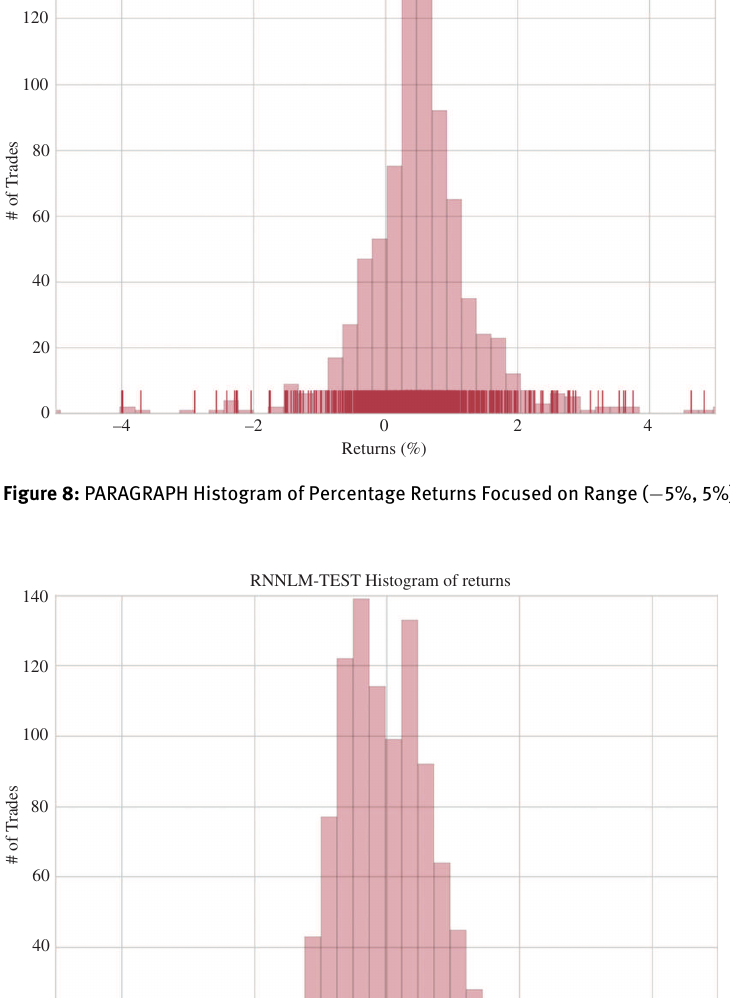
holding period is the ability to free up capital. A 0.6% return can be absorbed and reinvested to give com- pounding effects. Tables 7–10 report evaluation metrics for language and regression models on the validation and testing sets. On the evaluation metrics alone, text models undoubtedly outperform time-series models. Still, it is important to compare them separately since both are trading on different subsets of the data. The variance in the price an asset trades at explains why some strategies have a negative profit per share but positive returns. For example, on the validation set, SVR loses an average of − 0.04 cents per trade but has an average of 0.19% returns. SVR made a few bad predictions on stocks that trade at higher prices; this could be a large decline in cents but a small ratio according to percentage return. Nonetheless, the current regression techniques learn to be profitable with the selected representation. Only RNN 4 LSTM1 Dense model achieves a Sharpe ratio of over 2 across both validation and testing